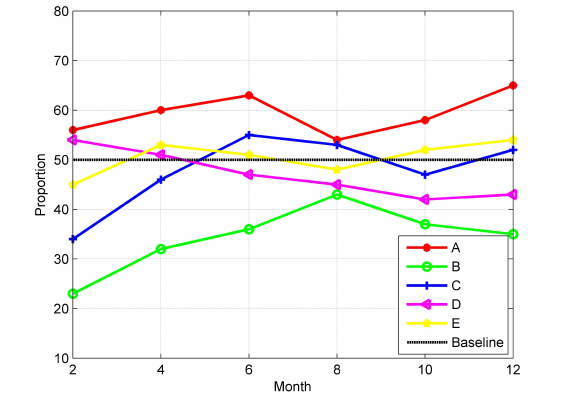
Figure 12. The negative reviews proportions of different